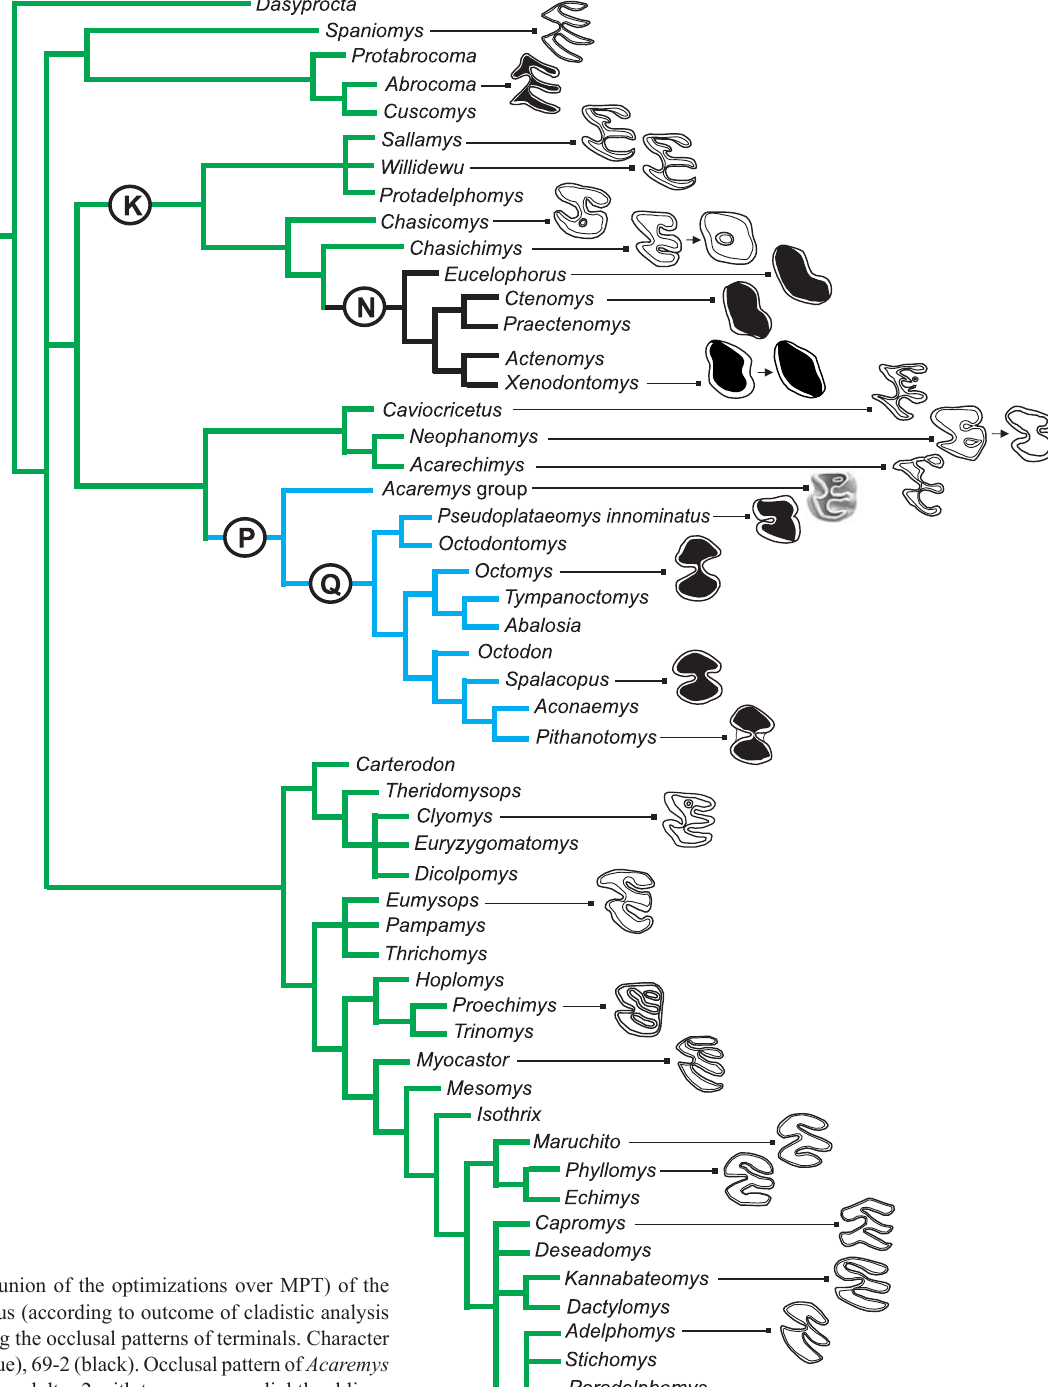
Fig. 6. Common mapping (union of the optimizations over MPT) of the character 69 on the consensus (according to outcome of cladistic analysis of Verzi et al. 2014), showing the occlusal patterns of terminals. Character states: 69-0 (green), 69-1 (blue), 69-2 (black). Occlusal pattern of Acaremys (including Sciamys ), showing adult m2 with transverse or slightly oblique lophids (see text), remarks the need to consider a polymorphic condition, character 69 [01], for this taxon. Occlusal figures of terminals represent left m1 or m2 and were essentially modified from Verzi et al. (2014: fig.